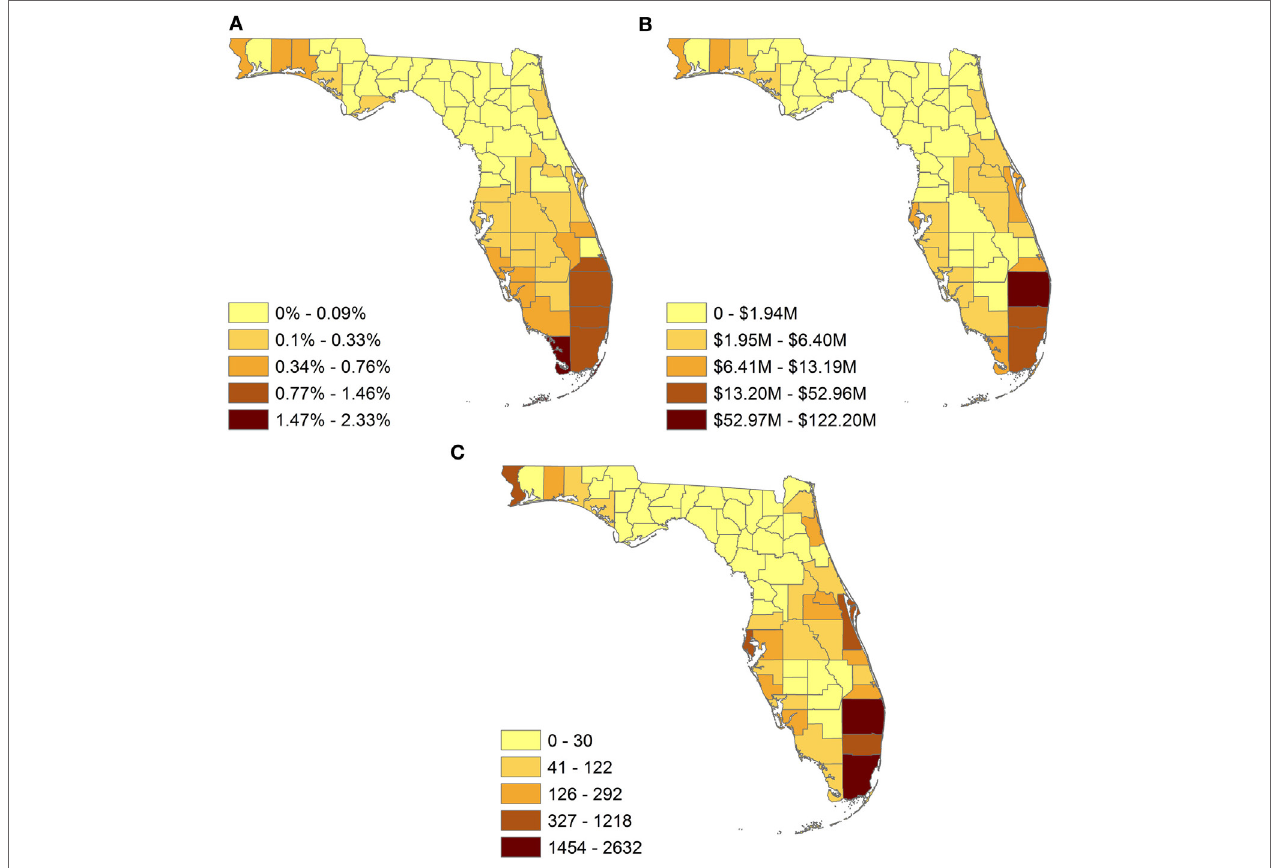
FigUre 6 | The comparison of different loss metrics in the regional scale: (a) average annual loss, (B) average annual dollar loss, (c) AAPL.